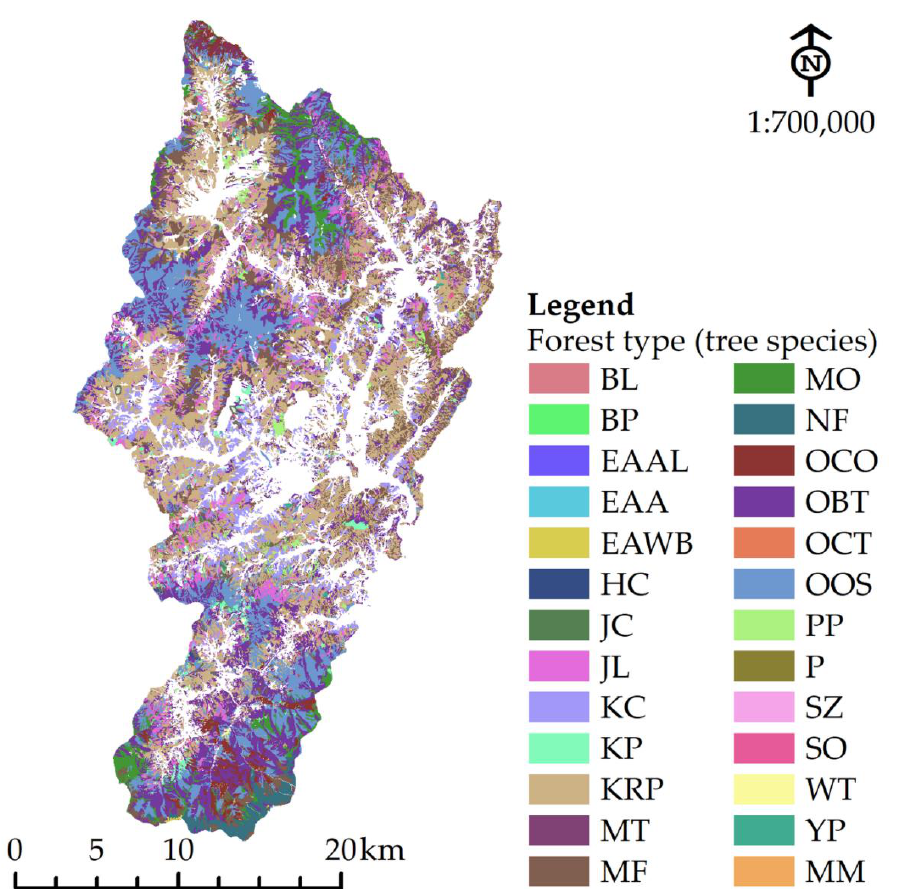
Figure 4. Thematic map for growth factor (forest type (tree species)) of WSG using the forest type map. Note: BL = Black locust, BP = Black pine, EAAL = East Asian alder, EAA = East Asian ash, EAWB = East Asian white birch, HC = Hinoki cypress, JC = Japanese cedar, JL = Japanese larch, KC = Korean castanea, KP = Korean pine, KRP = Korean red pine, MT = Maidenhair tree, MF = Mixed forest, MO = Mongolian oak, NF = Needle fir, OCO = Oriental cork oak, OBT = Other broadleaf tree, OCT = Other coniferous tree, OOS = Other oak species, PP = Pitch pine, P = Poplar, SZ = Sawleaf zelkova, SO = Sawtooth oak, WT = Walnut tree, YP = Yellow poplar, and MM = Mono maple.